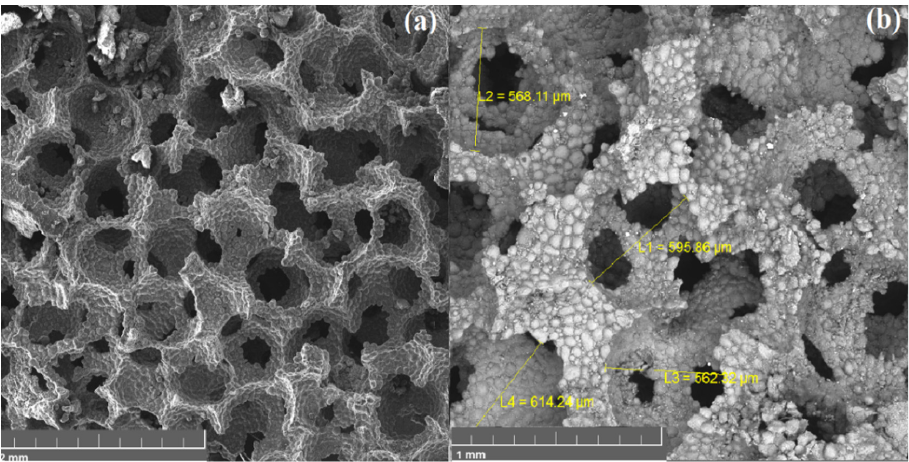
Figure 5. SEM image of foam obtained by SPS method: ( a ) general view, ( b ) pore size investigation.